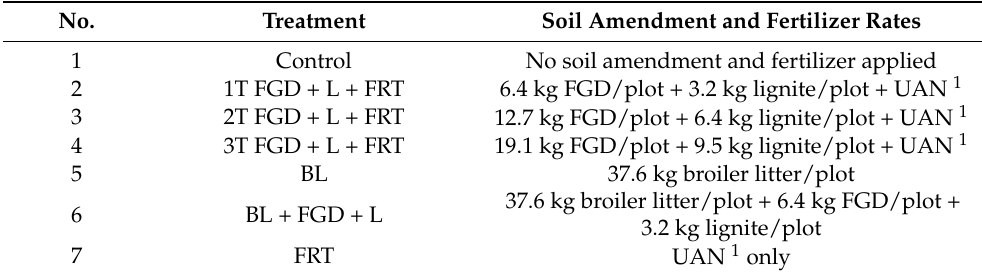
Figure 2. Study site located in Pontotoc, MS (left), and the experiment design plot showing the cover crop main plots and soil amendments subplots (right, not to scale). WCC: with cover crop; NCC: no cover crop. Table 2. Application rates of soil amendment and fertilizer of seven treatments.